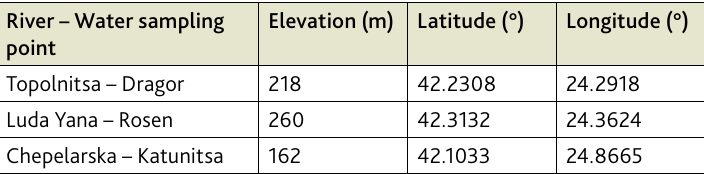
Table 1. Information about the location of water sampling points